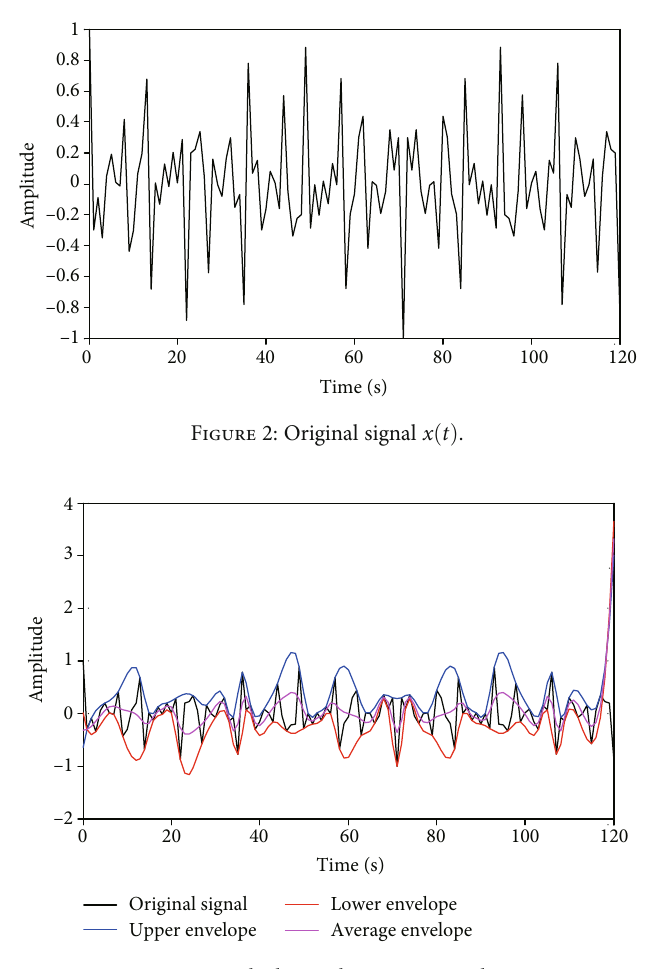
Figure 3: Calculating the average envelope.